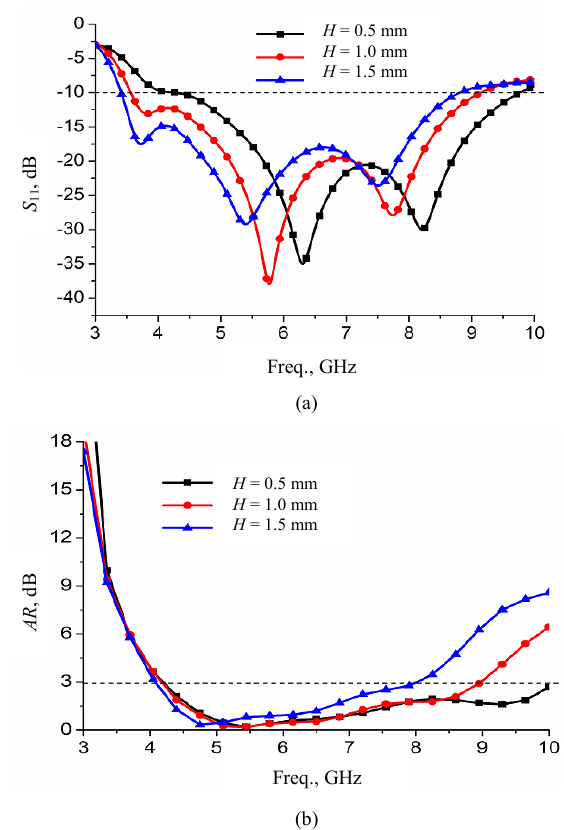
Fig. 5. Effect of ‘ H ’ on impedance bandwidth and axial